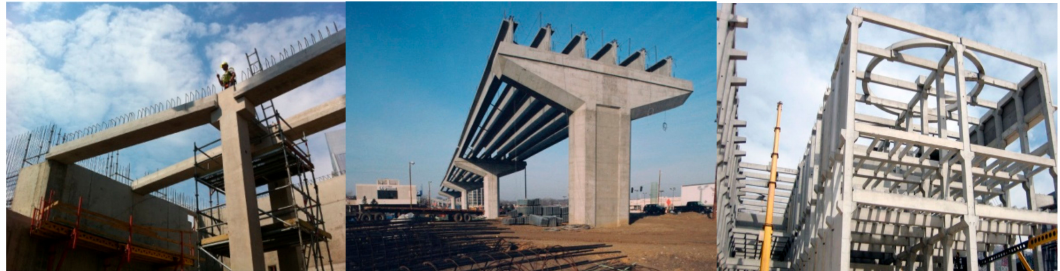
Figure 3. Examples of simply supported reinforced concrete beams of T, I, and rectangular cross-sections used in building structures.